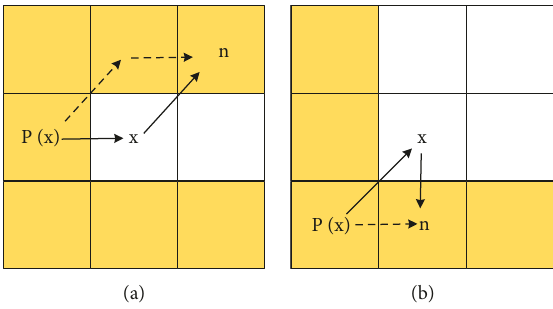
Figure 3: Non-natural neighbor nodes. (a) Linear direction. (b) Diagonal direction.